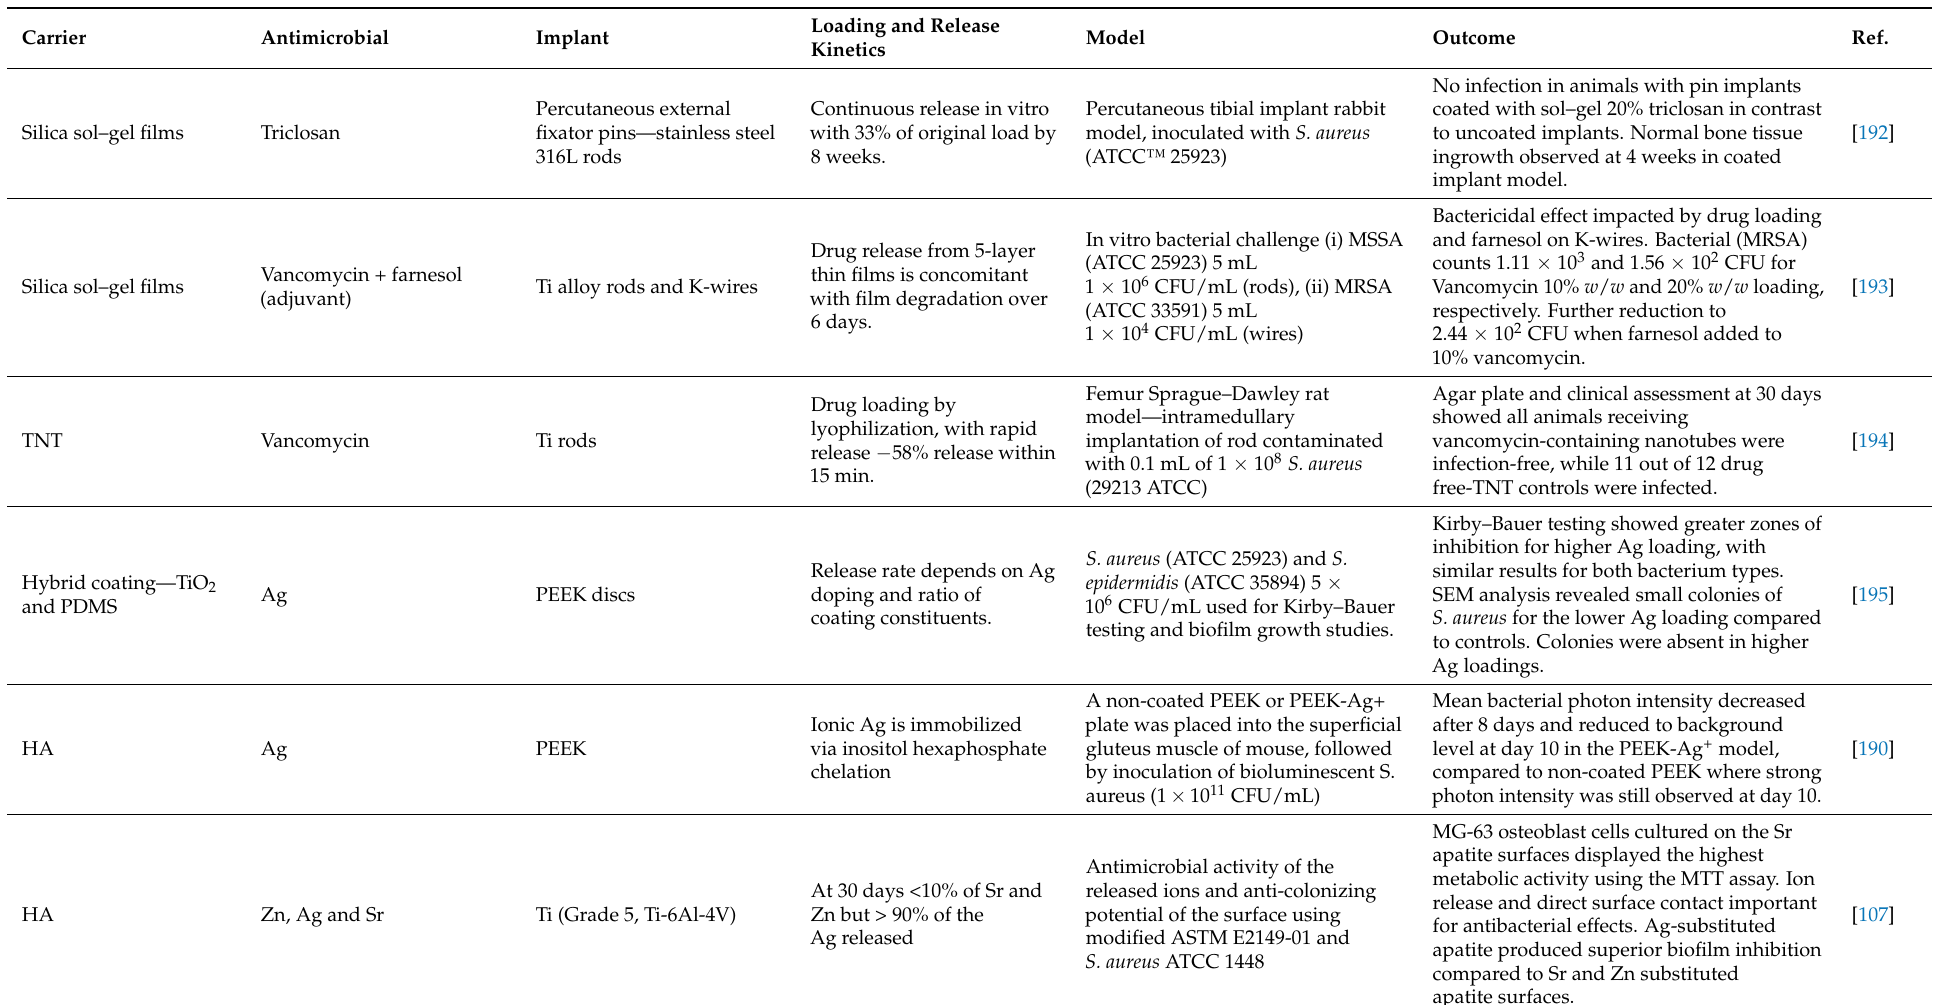
Table 3. Antimicrobial-containing inorganic coatings on orthopaedic implants. Table highlights the carrier type, antimicrobial, implant type, in vitro or in vivo model, antimicrobial release kinetics and experiment